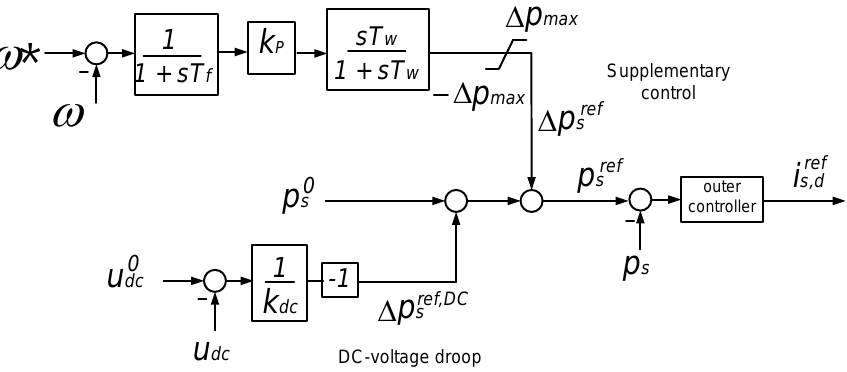
Figure 4. Control for the active-power injection of a VSC.